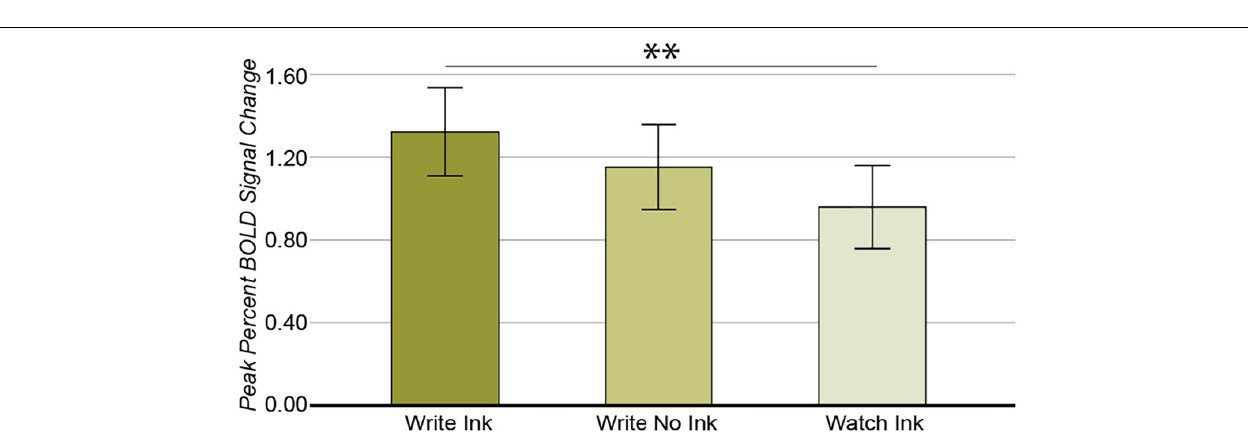
FIGURE 7 | Left dorsal precentral gyrus. Main effect of CONDITION. Error bars represent 95% confidence intervals. ∗∗ p <